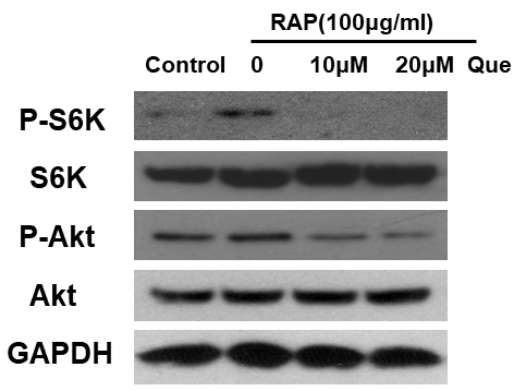
Figure 7. Activation of Akt and mTORC1/S6K pathways in RAW264.7 cells. RAW264.7 cells were treated with quercetin (10, 20 μ M) for 2 h and then treated with RAP (100 μ g/mL) for 30 min.